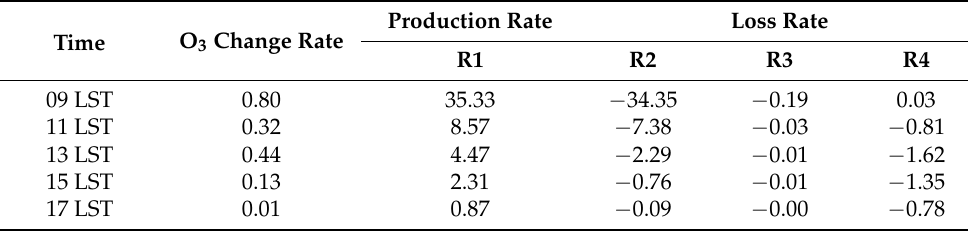
Table 3. Contribution of chemical reactions to the production and loss of O 3 during the analysis period (unit: